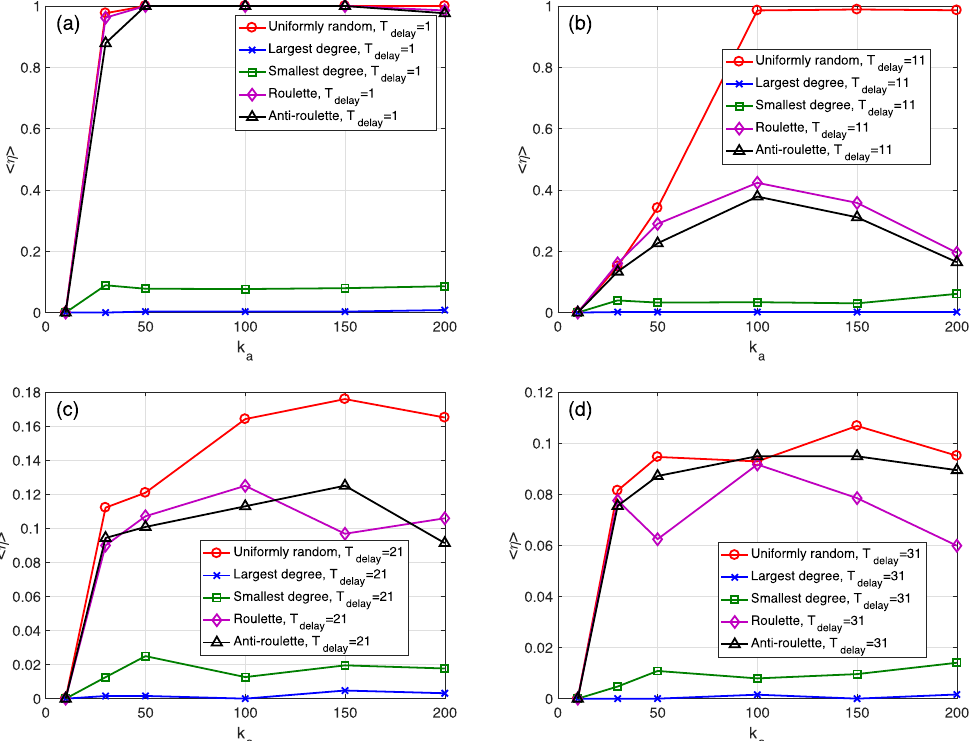
Figure 4. Mean survival ratio 〈 η 〉 as a function of k a for N a = 100. ( a ) Different selection rules for the ER network case with